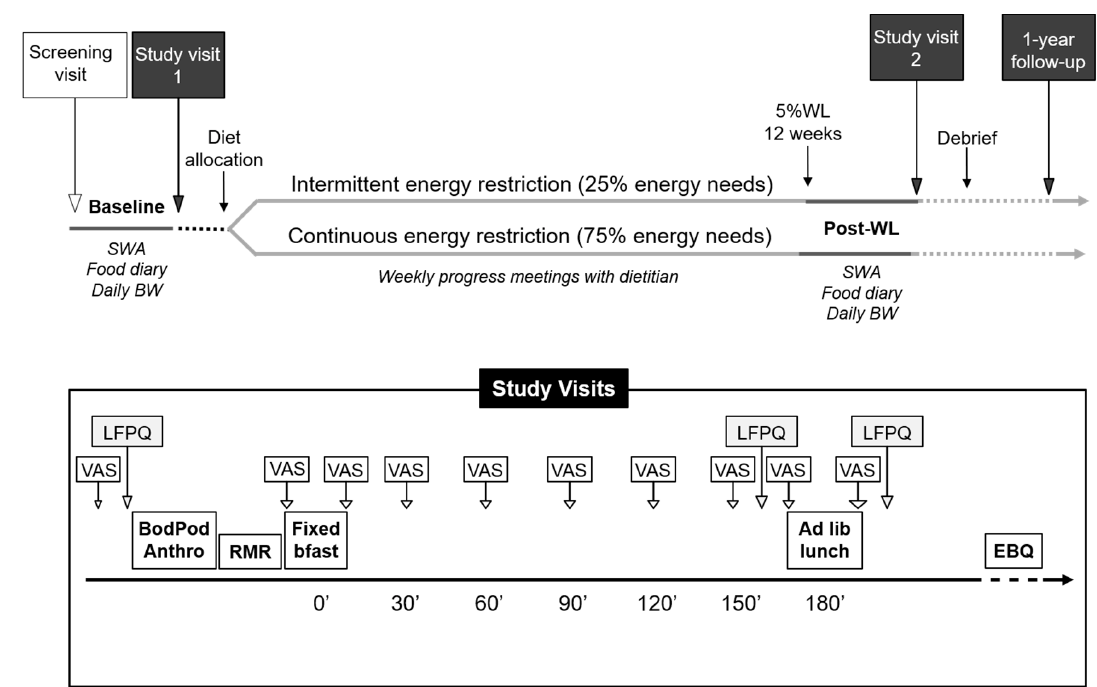
Figure A1. Design of the trial. Anthro: anthropometrics; Bfast: breakfast; BW: body weight; EBQ: eating behaviour questionnaires; LFPQ: Leeds Food Preference Questionnaire; RMR: resting metabolic rate; SWA, SenseWear Armband; VAS: visual analogue scales for appetite ratings; WL: weight loss.